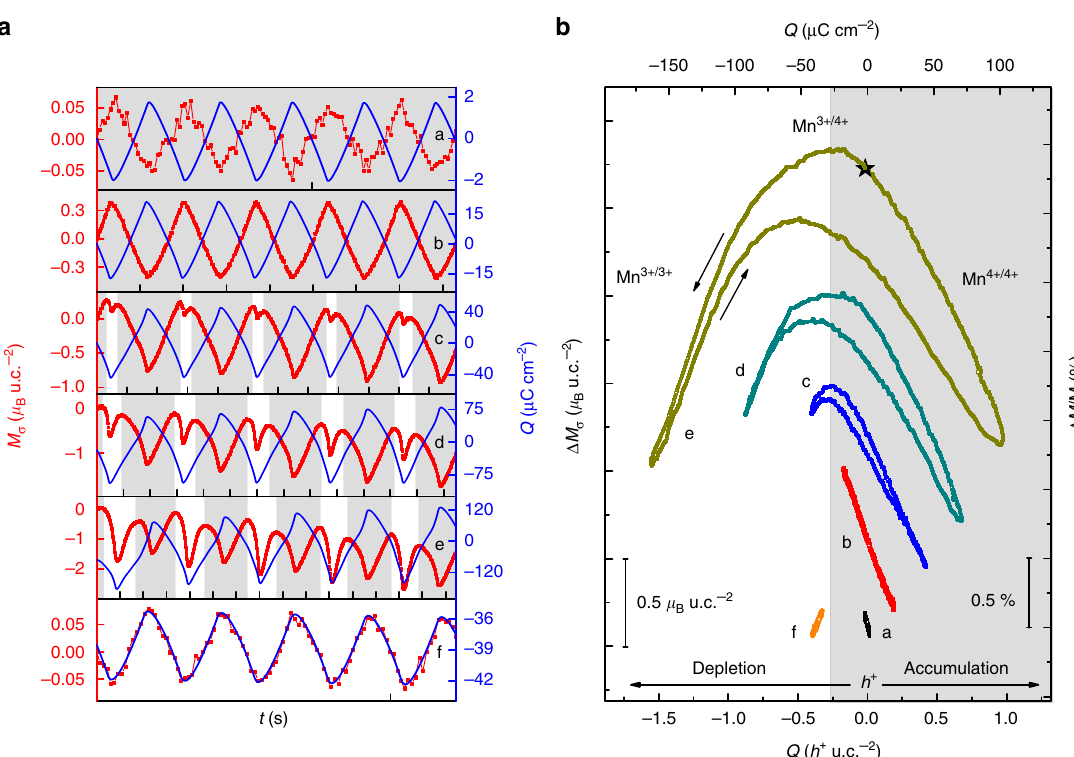
Figure 4 | Isothermal charge-dependence study at 220K. ( a ) Time-resolved magnetic responses on sequential increase of the surface charge modulation D Q from E 1.5 up to E 270 m Ccm (cid:2) 2 . The expected anti-phase response (plots a,b) reveals an in-phase splitting of the M ( t ) curve (plots c, d and e) on progressive electron doping, like the behaviour observed above T cross for a small potential window. The application of a bias voltage V b E (cid:2) 1.3V yielded an in-phase response (plot f). Each time step on the abscissa corresponds to 800s. ( b ) Behaviour of the magnetization as a function of the surface charge doping. The slope of the M ( Q ) curves corresponds to the ME coupling coefficients a . The small variation in D M / M underlines the interfacial nature of the magnetic tuning effect at low temperature. In a , b , the white and grey areas qualitatively separate the data with the LSMO magnetization responding to the applied surface charge as above or below T cross ,